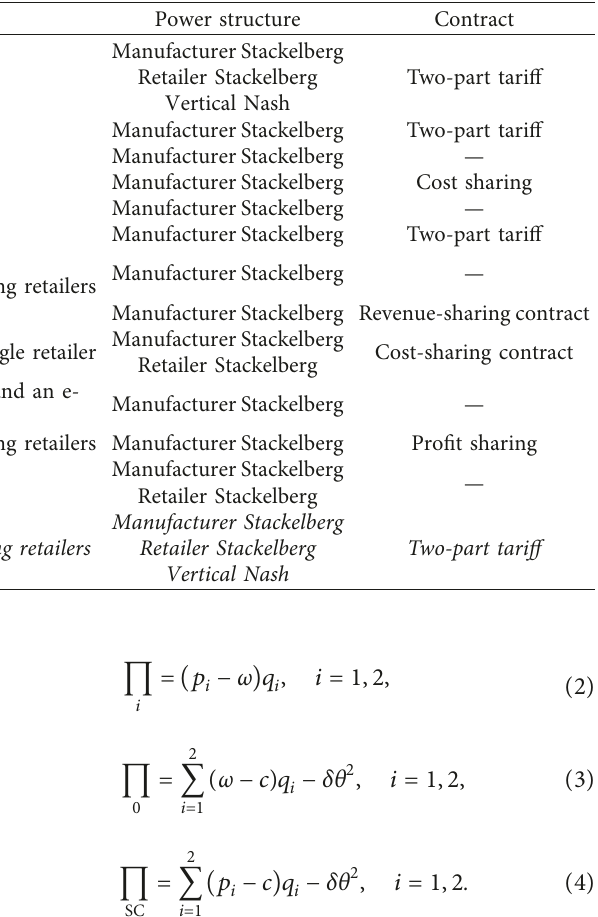
Table 1: Comparison of previous models with the current